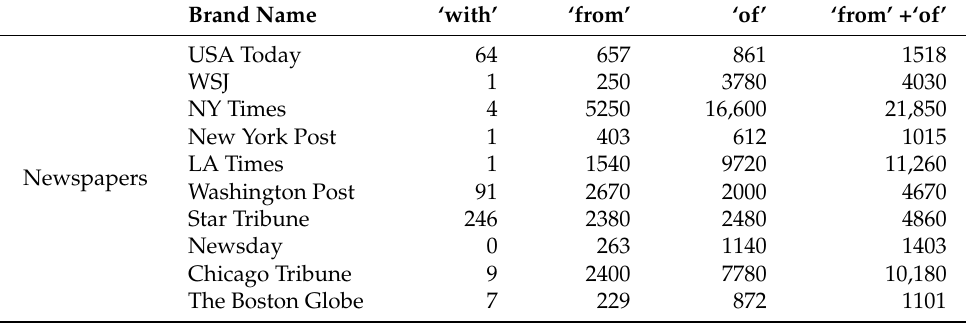
Table 2. Summary of USA